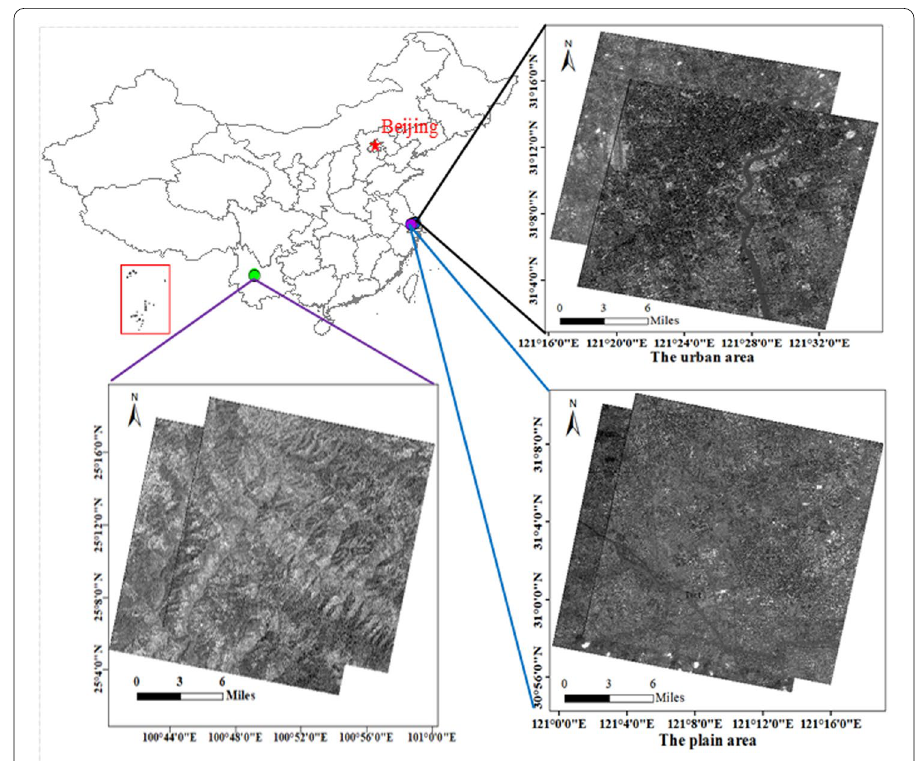
Fig. 2 Three study areas with different terrains in China: urban, plain, and mountainous